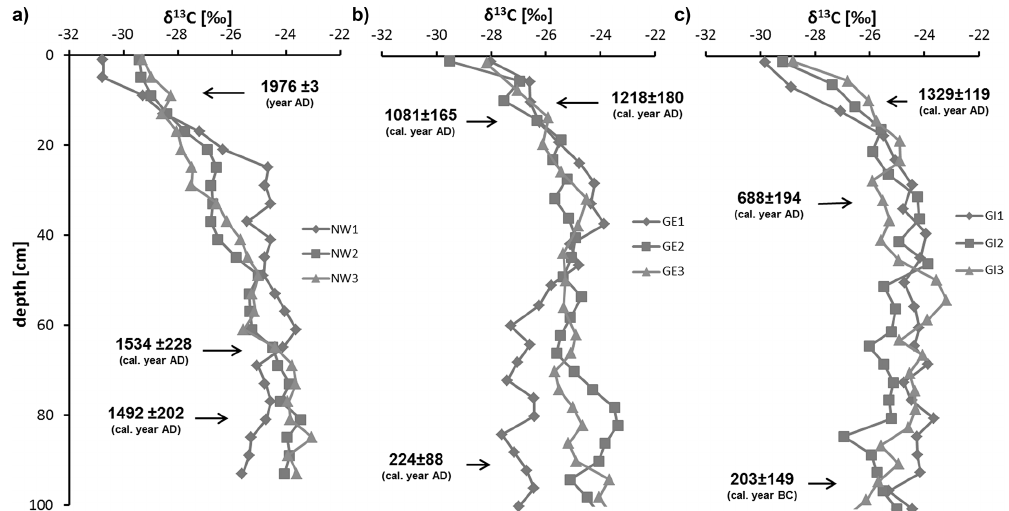
Figure 2. δ 13 C depth profiles at (a) the near-natural site (NW), (b) extensively used grassland site (GE) and (c) intensively used grassland site (GI) at the Ahlen-Falkenberger peatland. Calibrated radiocarbon ages are displayed as mean calendar ages with 1 standard deviation ( n = 3) at their corresponding depth.